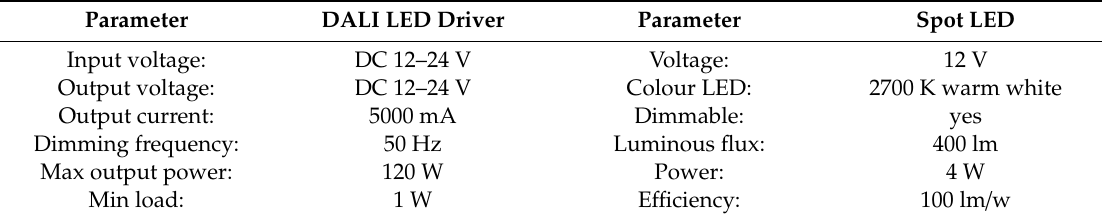
Table 2. DALI Light emitting diode (LED) driver and LED